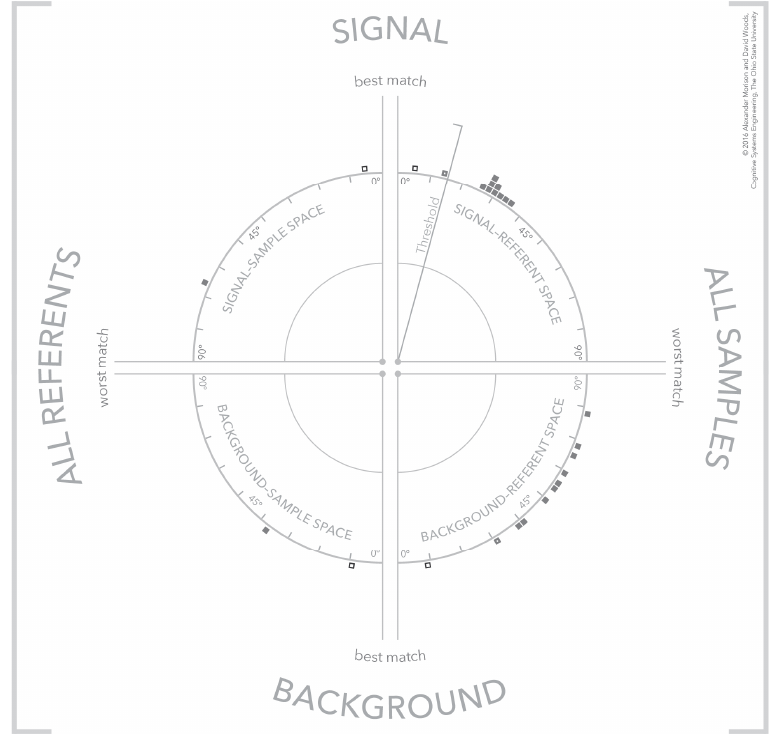
Figure 10. The visualization illustrating two different types of samples, a confusor (thin outlined box) and a tentative signal detection (thick outlined box).